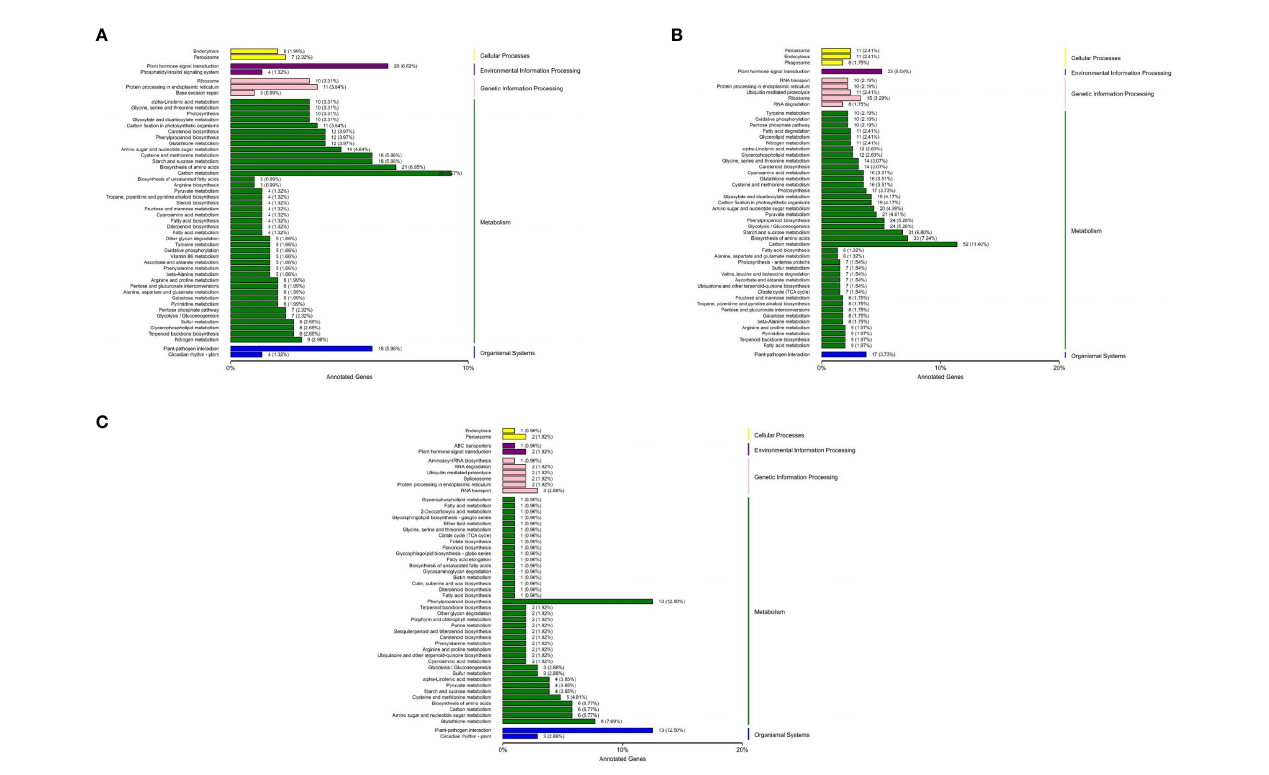
FIGURE 1 KEGG classi fi cation of differentially expressed genes in the different test materials. (A) KEGG classi fi cation of differentially expressed genes between BQ and DK. (B) KEGG classi fi cation of differentially expressed genes between BQ and ZJ. (C) KEGG classi fi cation of differentially expressed genes between DK and